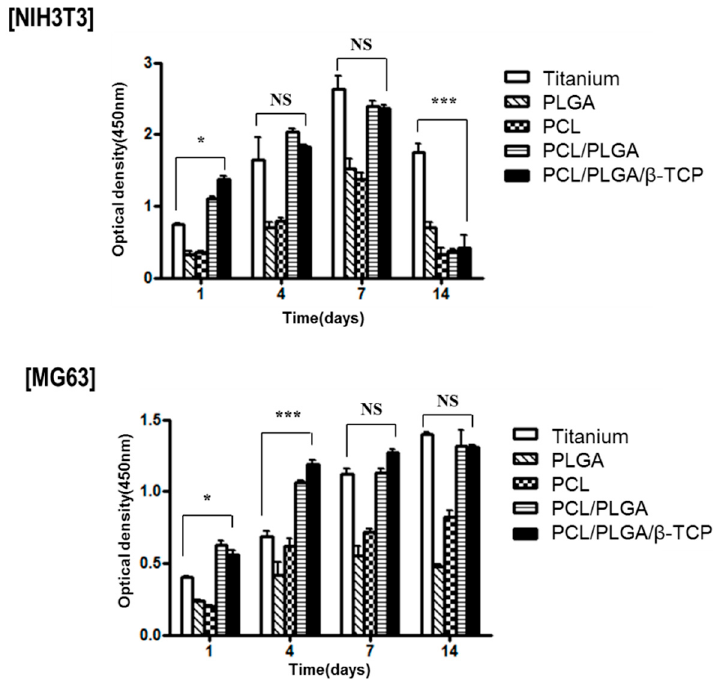
Figure 9. The cell proliferation assays of NIH3T3 and MG63 cells (* p < 0.05, *** p < 0.001; NS, no significant difference).